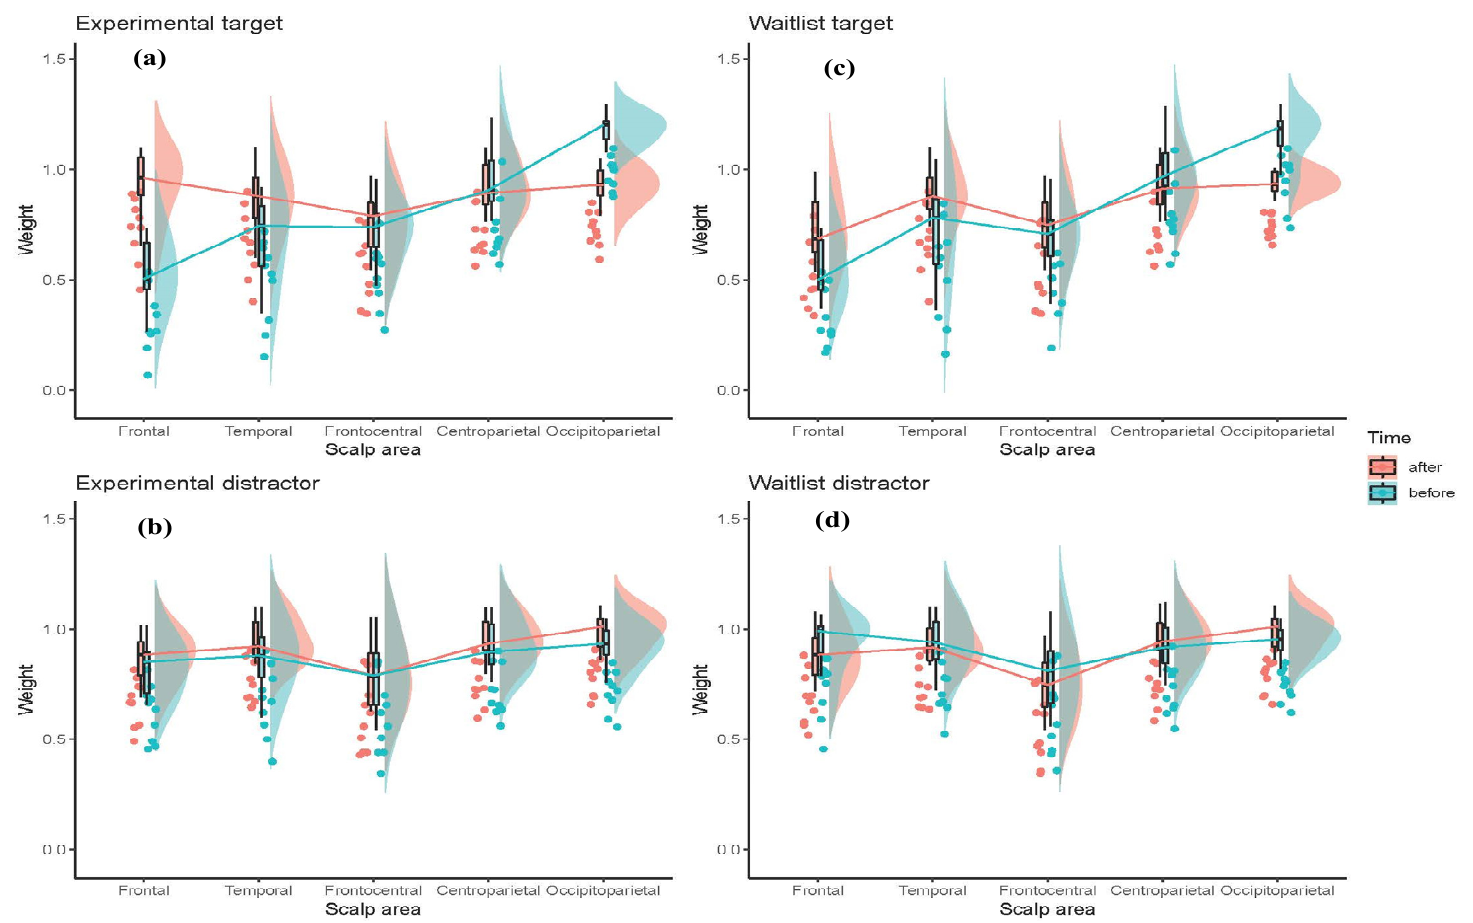
Figure 10. The SNN connection weights distribution related to “before” mindfulness (green colour) and six weekly mindfulness follow-ups (pink colour) across five sites of the brain (frontal, temporal, frontocentral, centroparietal, and occipitoparietal) in experimental and waitlist groups in response to ( a , c ) target stimuli and